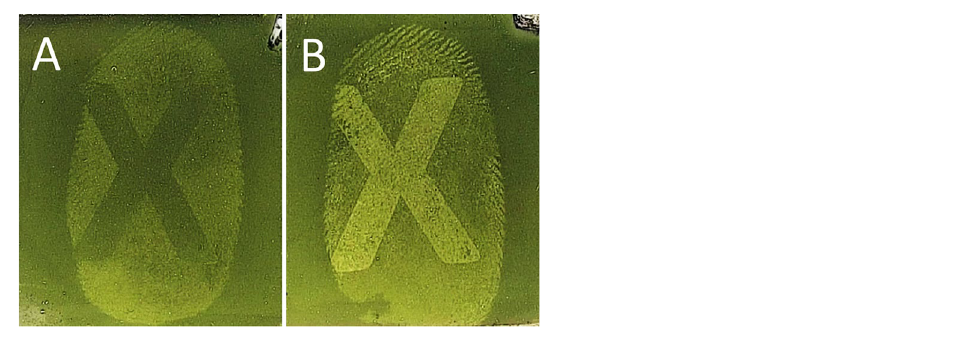
Figure 3. Gelatin lifted samples of fingermarks placed prior to printing an X ( A ), and on top of a printed X ( B ), developed in the RECOVER